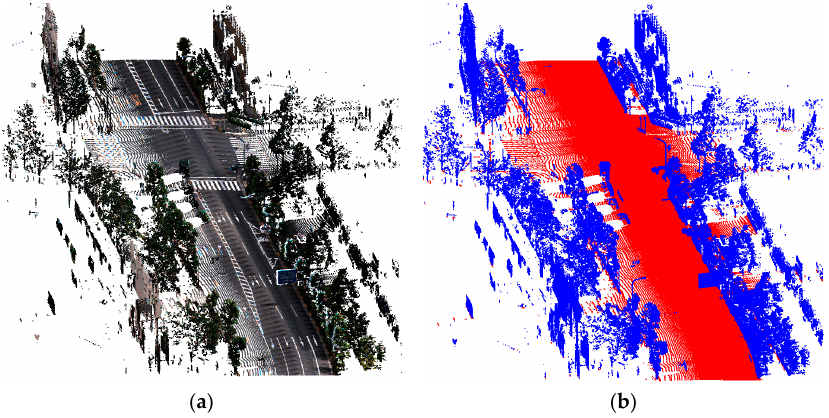
Figure 8. Road segmentation from an MMS point cloud: ( a ) original MMS point cloud consisting of buildings, trees, vehicles and road signs (RGB color is derived from the camera); and ( b ) the result of ground segmentation. The red points represent the ground, and the blue points are off-ground.